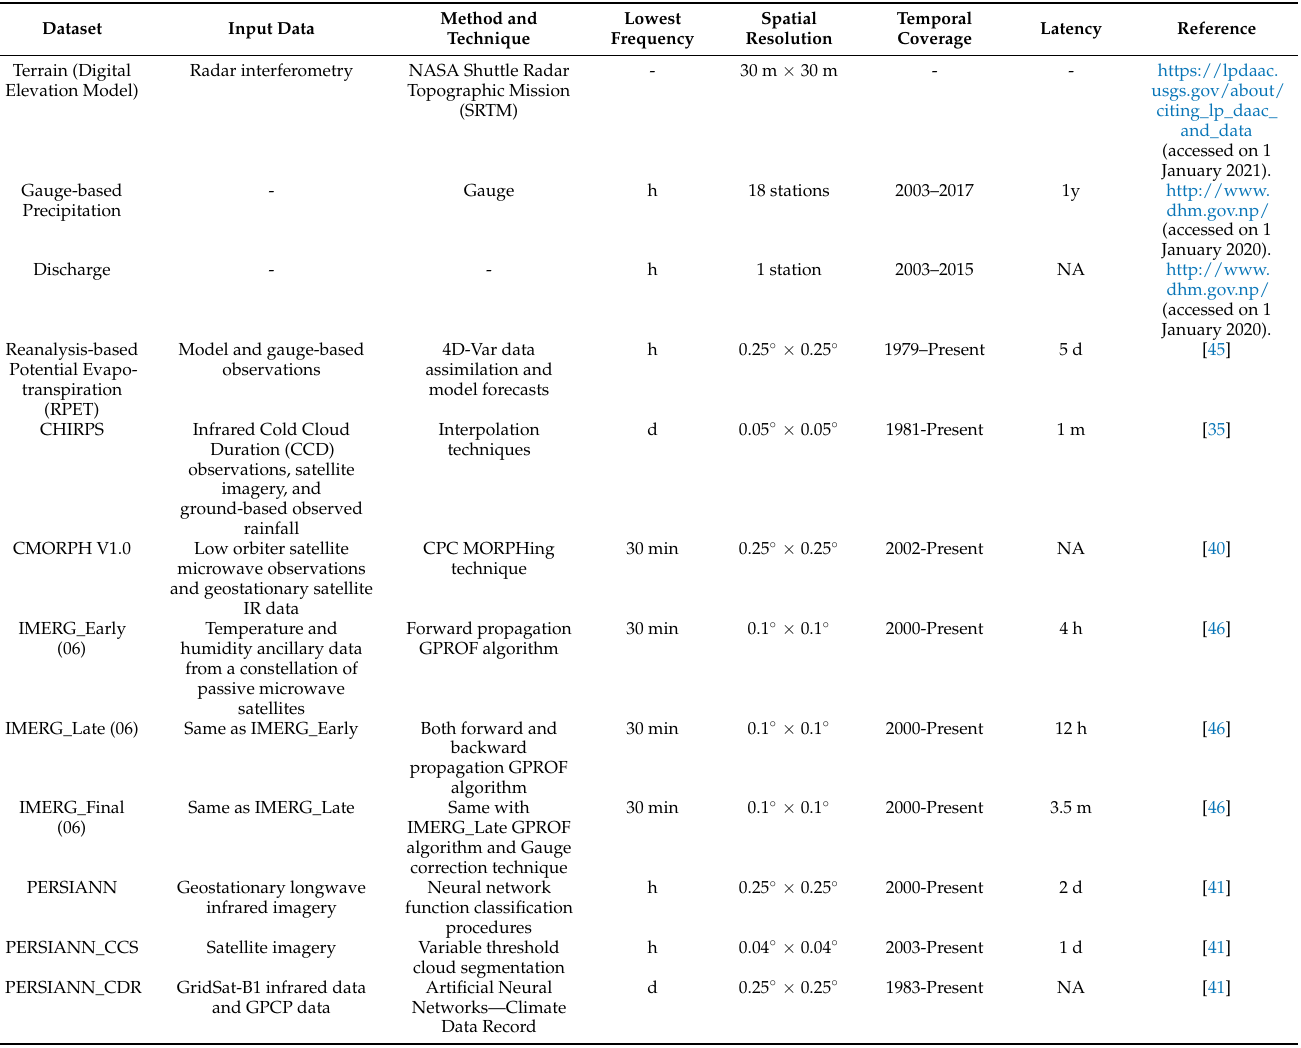
Table 1. A brief description of the datasets used in the present